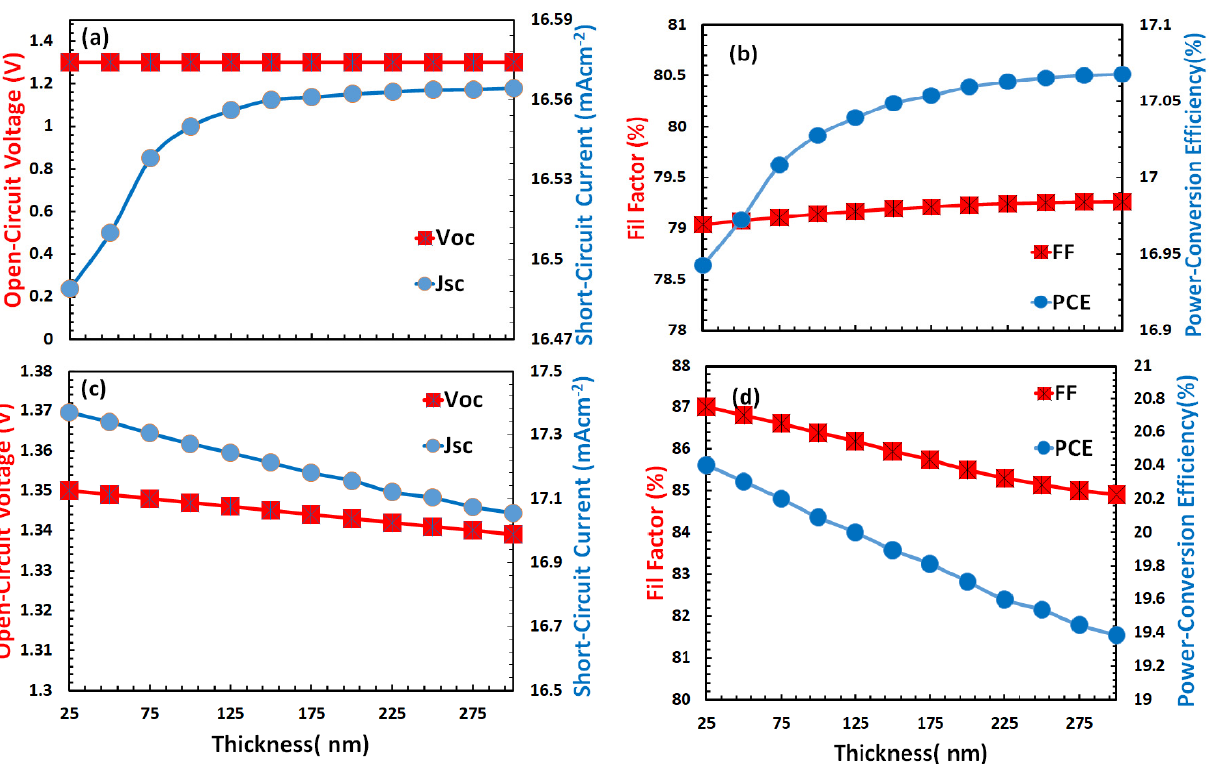
Figure 6. ( a ) Open-circuit voltage, short-circuit current, ( b ) fill factor, and power conversion efficiency of HTL as a function of electron affinity. ( c ) Open-circuit voltage, short-circuit current, ( d ) fill factor, and power conversion efficiency of ETL as a function of film thickness for Cs2TiBr6-based solar cell.